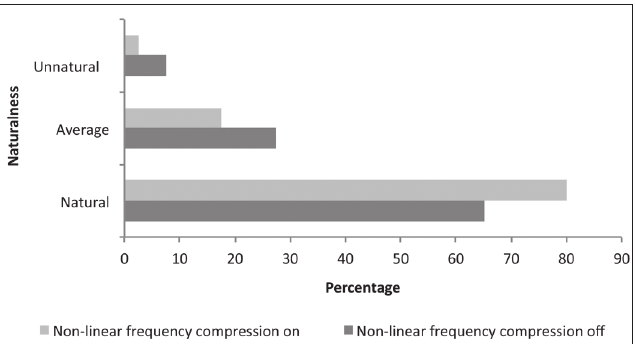
Fig. 5. Participants’ perception of the naturalness of music with NFC off versus NFC on.